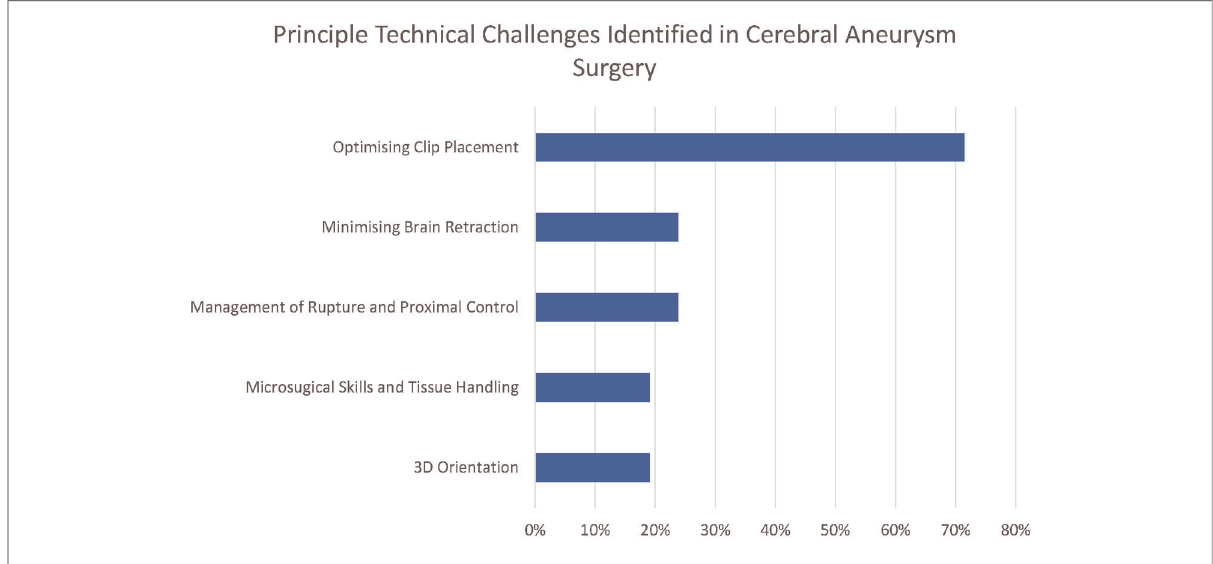
FIGURE 2 5 Principal technical challenges identi fi ed in cerebral aneurysm